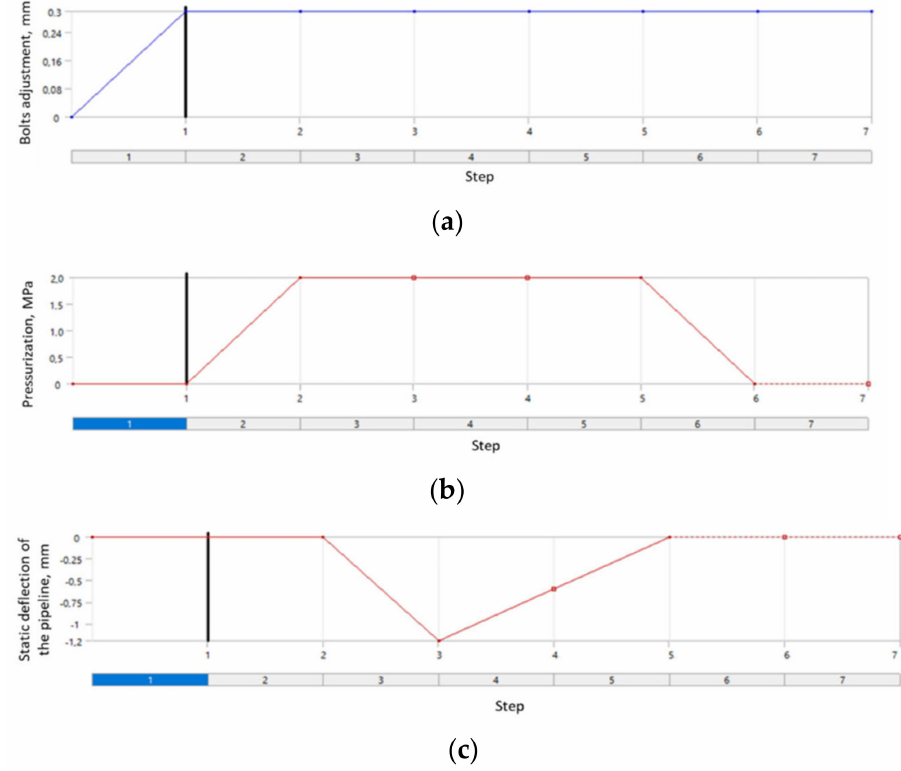
Figure 13. Steps of numerical analysis: ( a ) tensioning of bolts; ( b ) loading with pressure; ( c ) static deflection of the pipeline’s